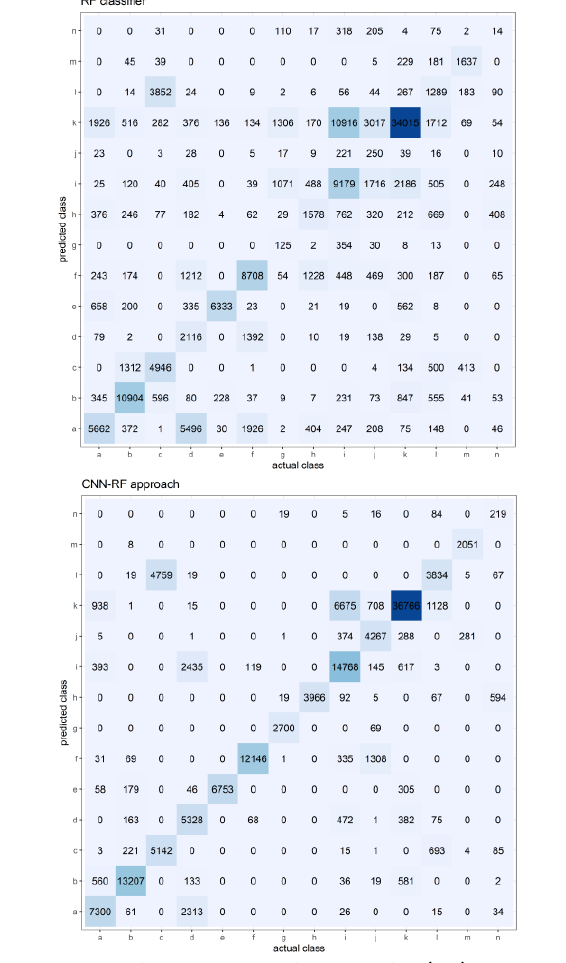
Figure 5. Confusion matrices of RF classifier (top) and CNN- RF approach (bottom). Note: Species ID according to Table